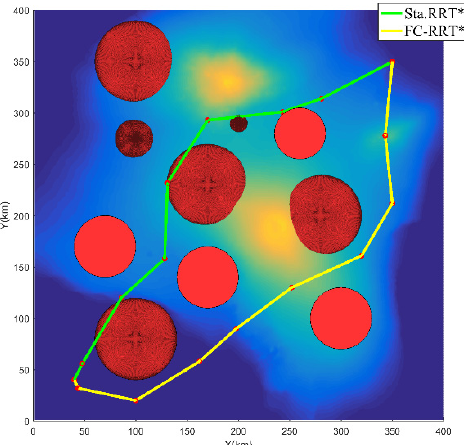
Figure 10. The 2D image of Figure 9.